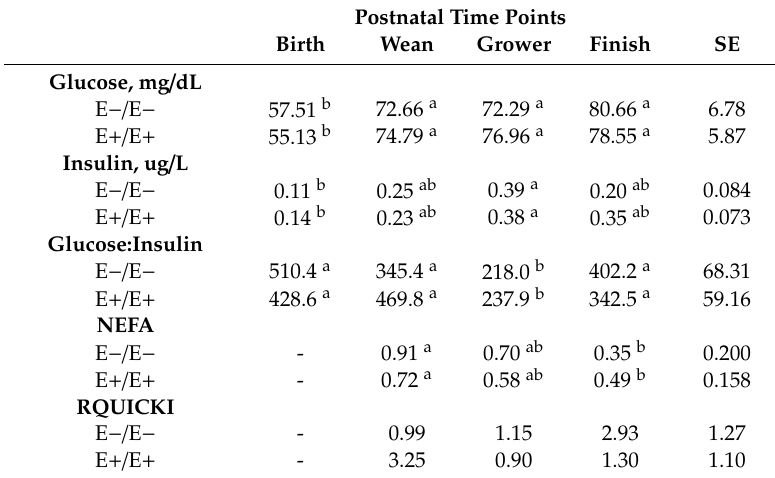
Table 7. Concentrations of plasma glucose and insulin, serum non-esterified fatty acids (NEFA) and revised quantitative insulin sensitivity chek index (RQUICKI) from wethers born to ewes consuming endophyte-infected (E + ) or endophyte-free (E − ) fescue during MID (d 35-85) and LATE (d 86- parturition) gestation at specific time points during postnatal growth. Postnatal Time Points Birth Wean Grower Finish SE Glucose, mg /